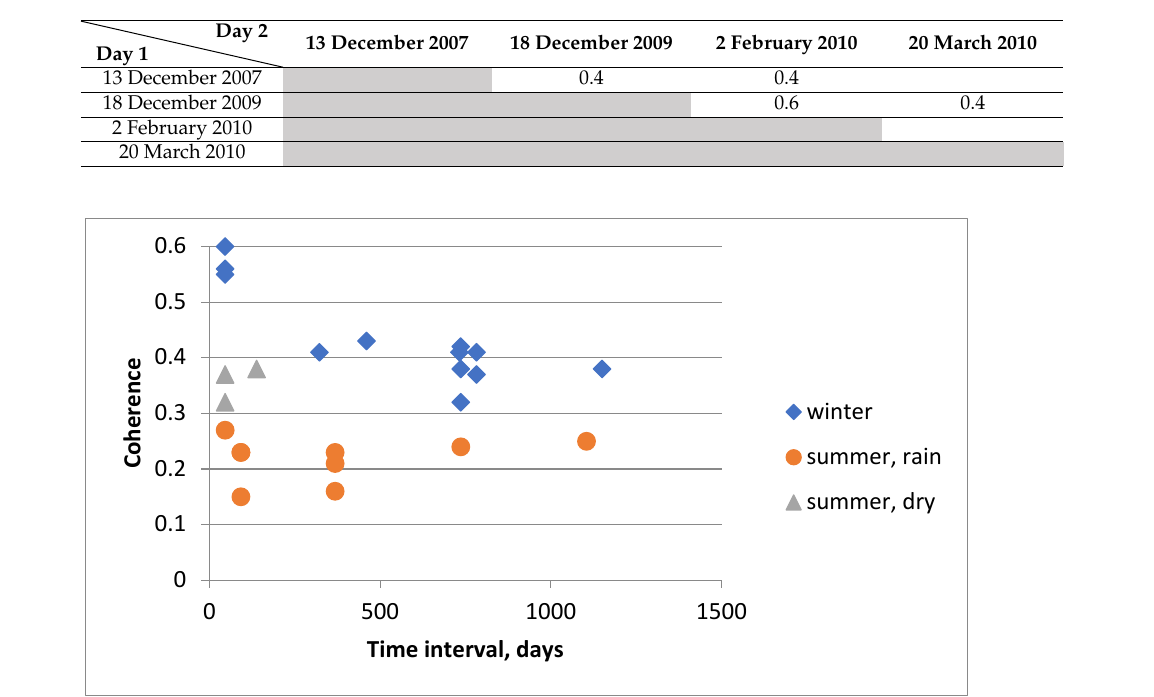
Table 3. PALSAR coherences, track 415.